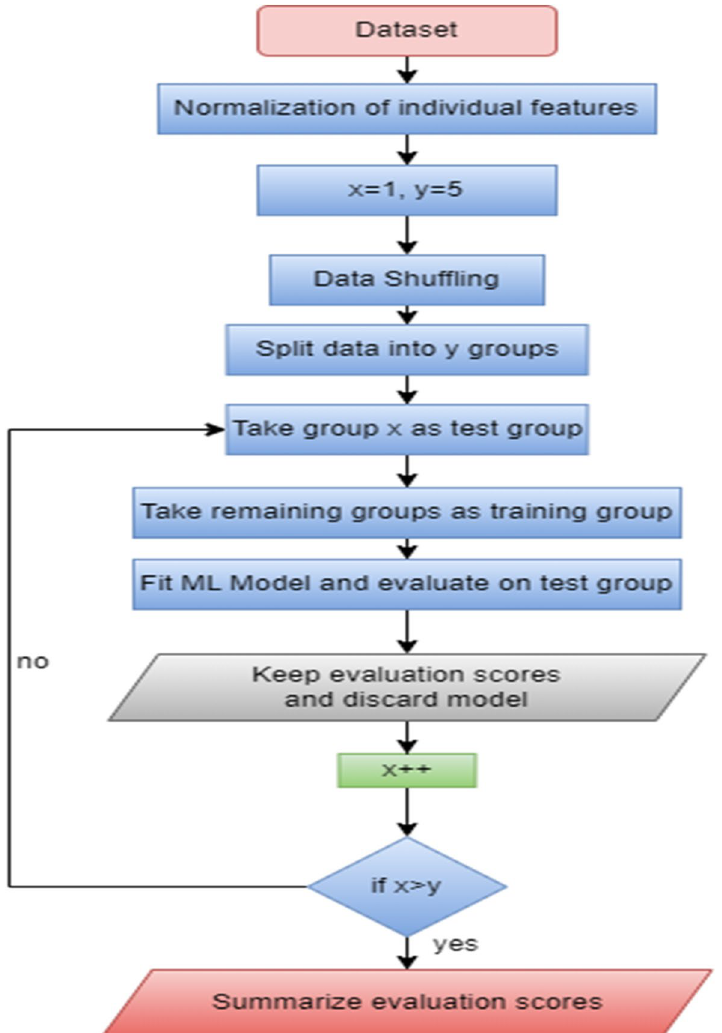
Fig. 2 Schematic of the machine learning model